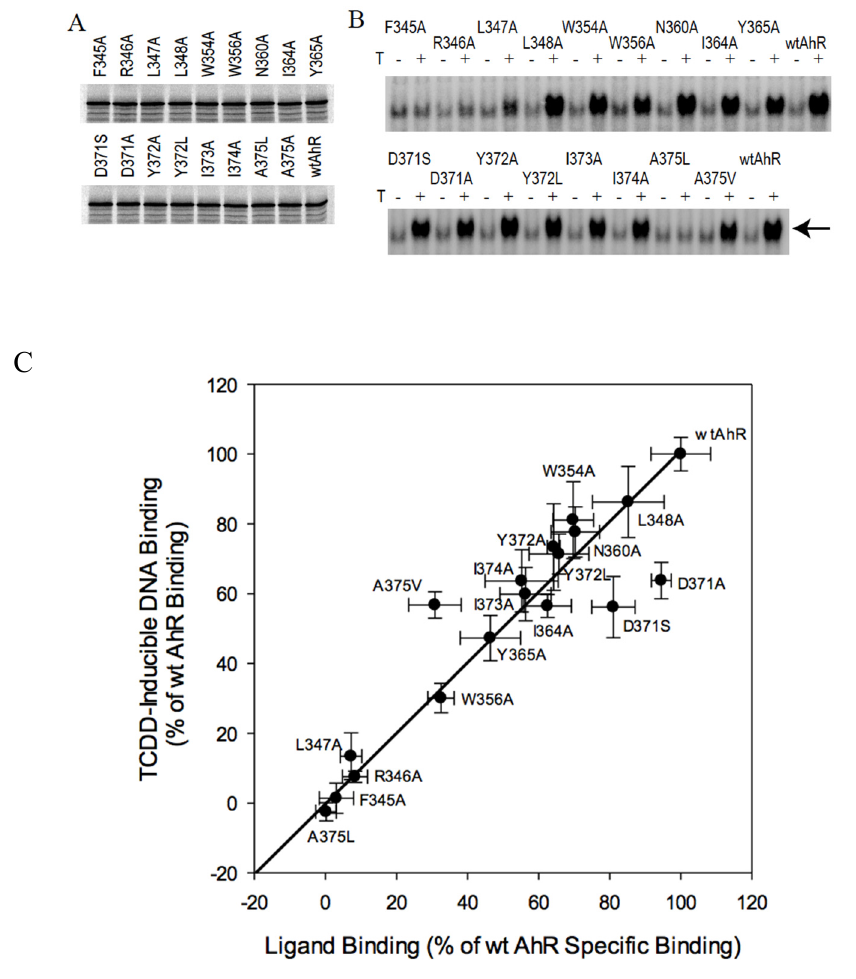
Figure 3. E ff ects of mutagenesis of select amino acids within residues 345–375 of the AhR PASB on TCDD-inducible AhR transformation / DNA binding and [ 3 H]TCDD specific binding. ( A , B ). In vitro analysis of the wild type (wt) and mutant AhRs was as described in the legend to Figure 2. ( C ) Comparison of ligand binding and ligand-dependent DNA binding for wt and mutant AhRs was as described in the legend for Figure 2C. Note: mutations of Asp371 (D371A, D371S) demonstrate proportionally lower DNA-bound to [ 3 H]TCDD-bound ratios, with experimental points to the right of the trend line. Values represent the mean ± standard deviation of triplicate independent binding reactions and the specific results presented are representative of at least three independent experiments.